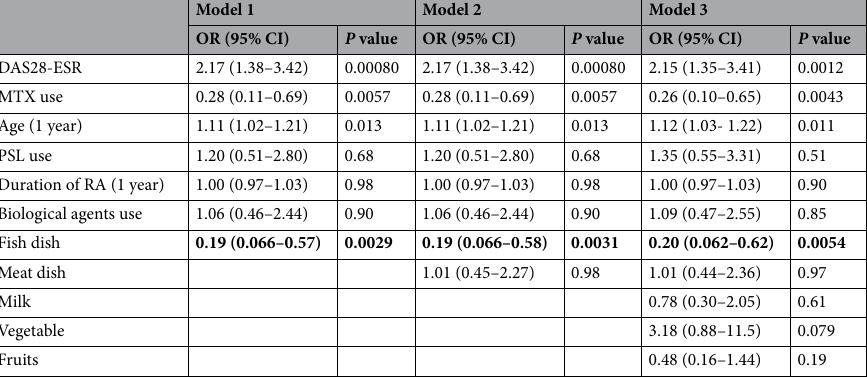
Table 5. Multivariate logistic analysis for RA patients over 65 years old with prefrailty or frailty including factors of dietary habits. Results of multivariate logistic regression analysis with dietary habits and RA-related factors regarding the presence of prefrailty or frailty in RA patients aged 65 years and older. Model was adjusted for age, RA duration, RA therapeutics (use of prednisolone, biologics and methotrexate), DAS28-ESR, and dietary habits (only fish dish (model 1), fish + meat dishes (model 2) and fish/meat/milk/vegetable/fruits (model 3) as variables). Dummy variables were constructed for intake frequency as 0 and 1: Fish and Meat dish: 0 = low frequency (≤ 2 times/weeks), 1 = high frequency (3 times/week ≤) and Milk, Vegetable and Fruits: 0 = low frequency (≤ 6 times/week), 1 = high frequency (1 time/day ≤). RA rheumatoid arthritis, DAS28-ESR 28-joint Disease Activity Score using erythrocyte sedimentation rate, MTX methotrexate, PSL